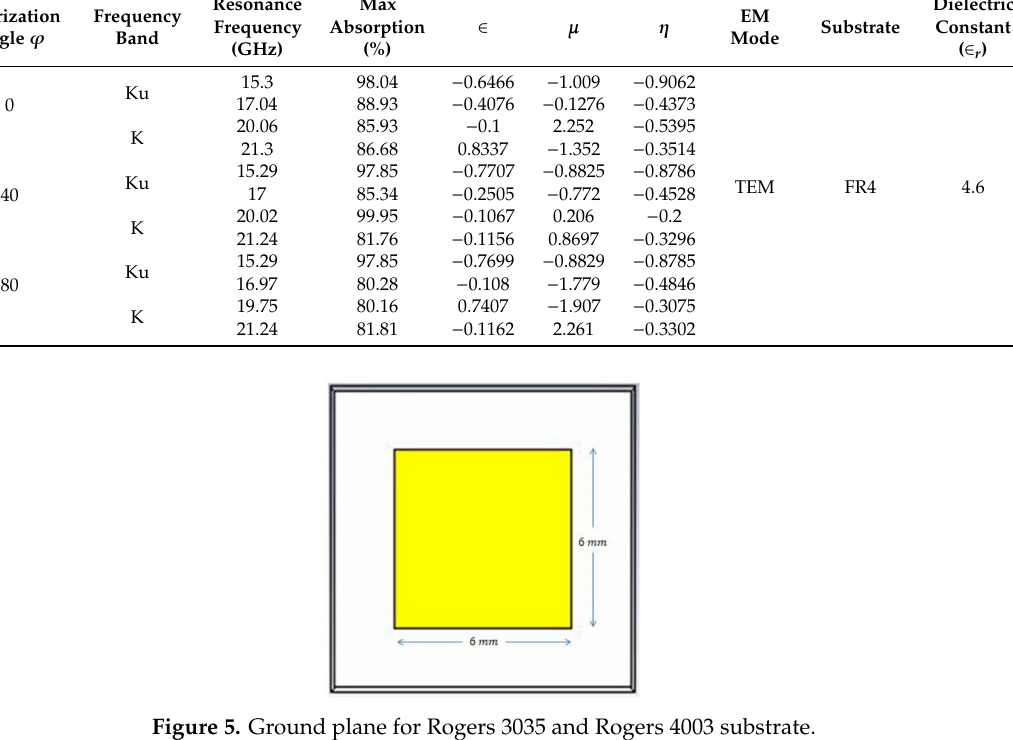
Figure 5. Ground plane for Rogers 3035 and Rogers 4003 substrate.